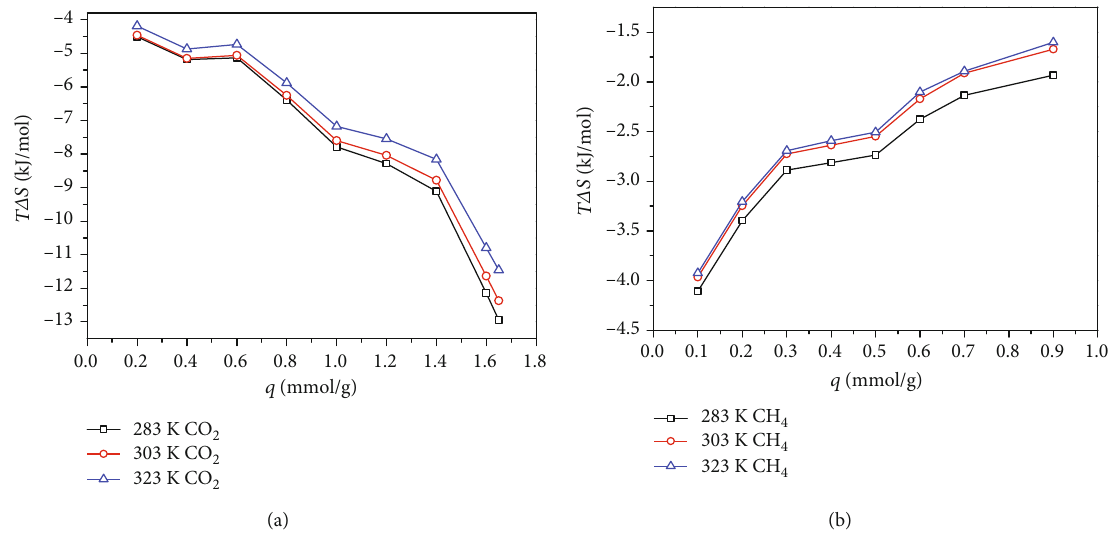
Figure 11: Entropy changes of CO